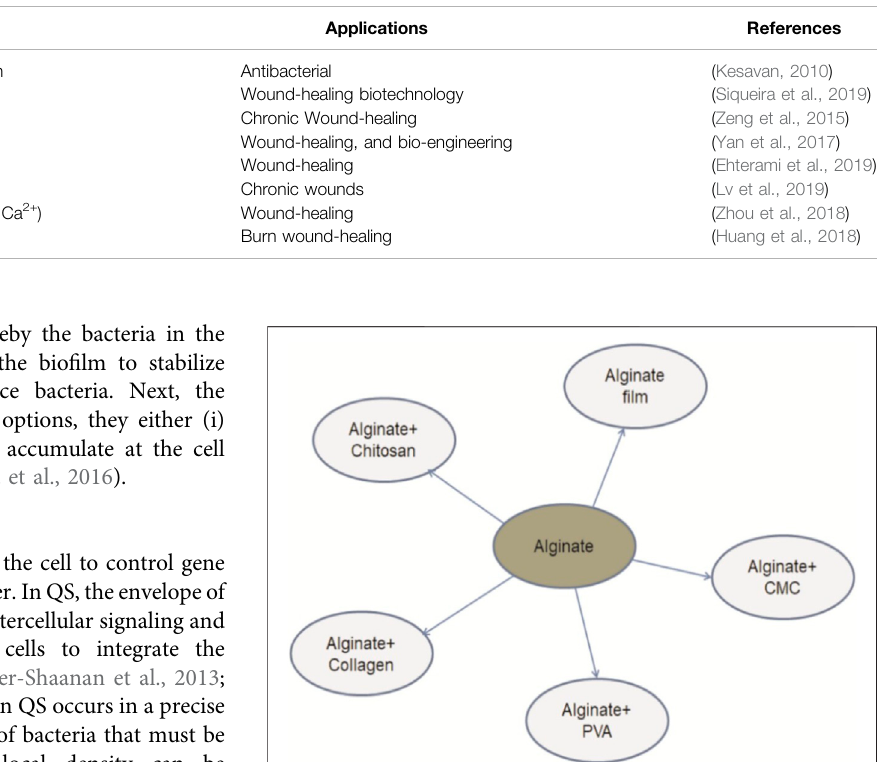
TABLE 1 | Hydrogels derived from modi fi cations to alginate and their applications.